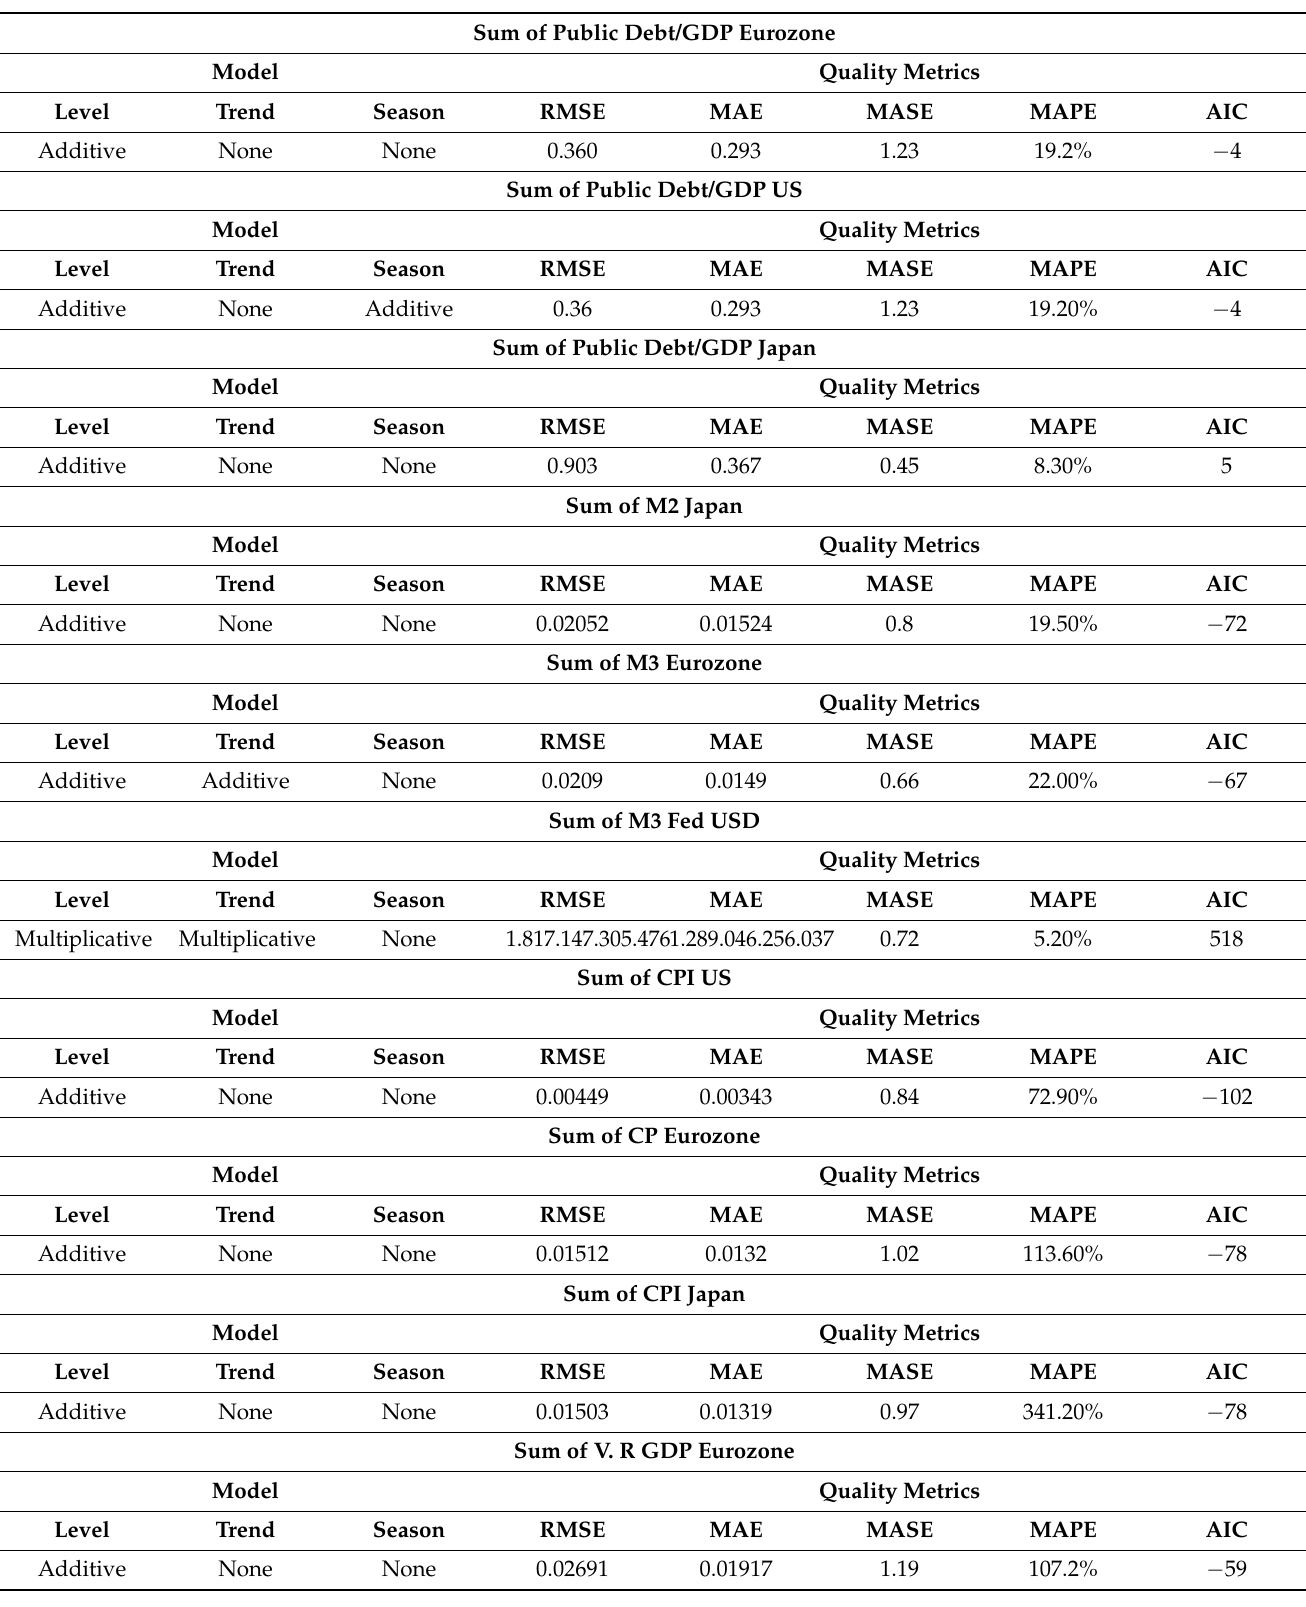
Table 4. Model and quality